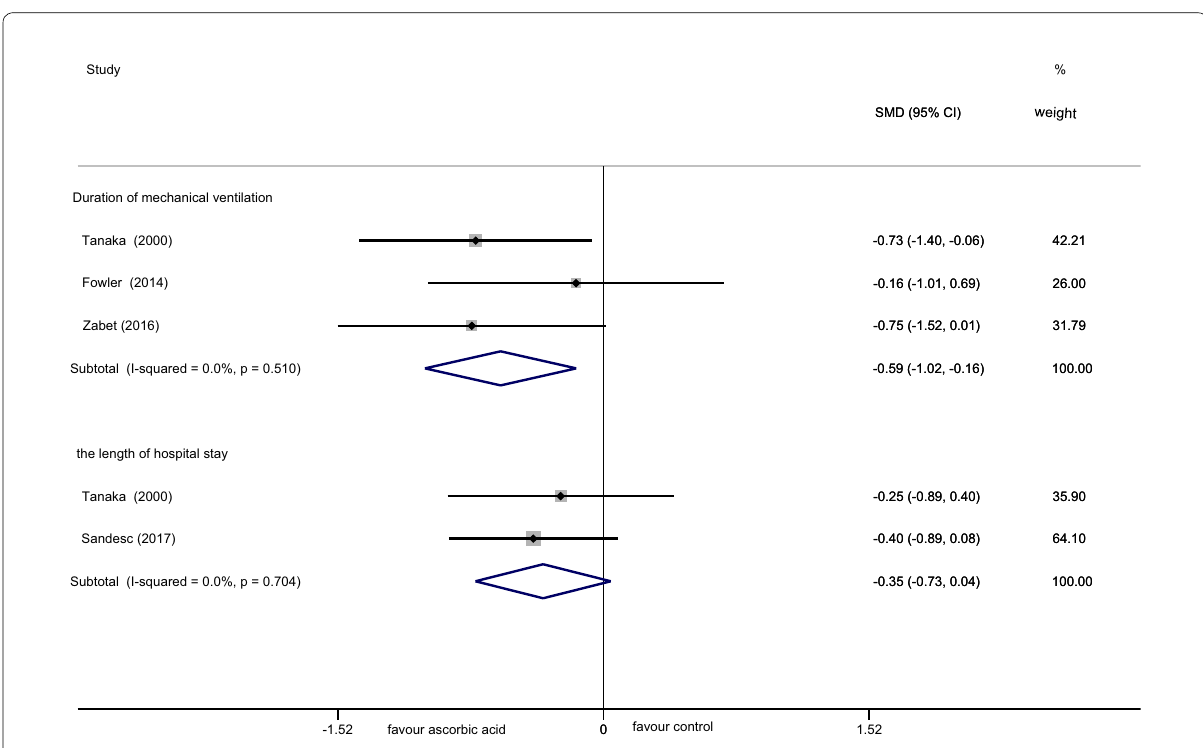
Fig. 6 Forest plot of the effect of IV AA on the duration of mechanical ventilation and the length of hospital